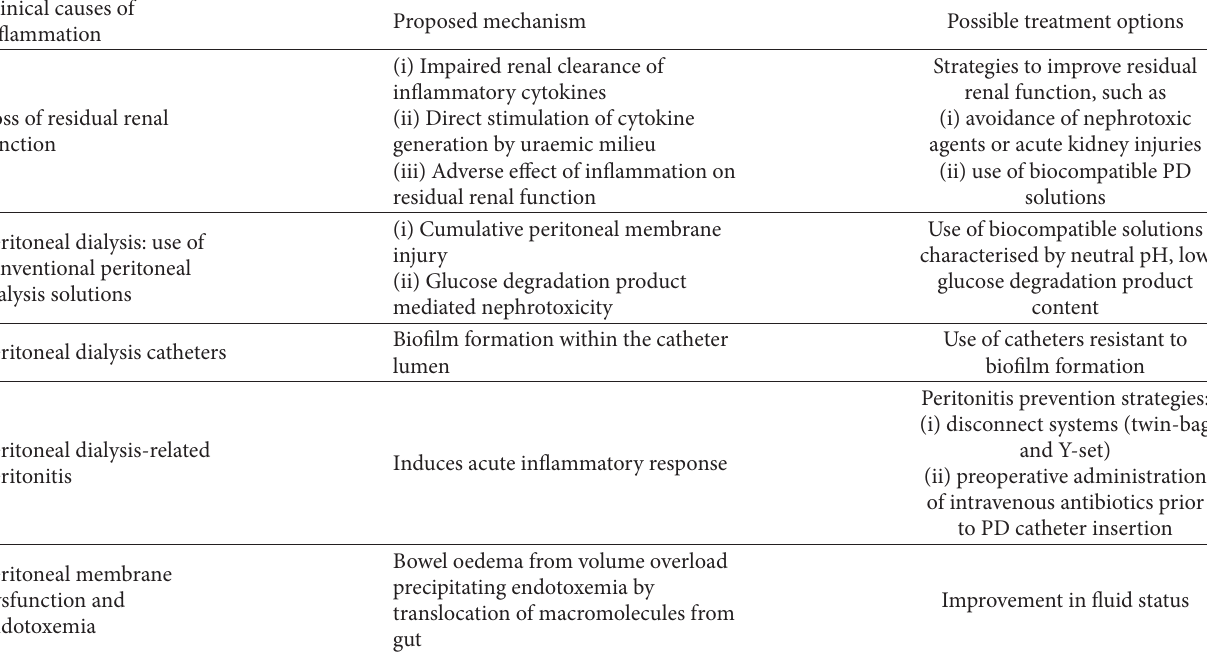
Table 1: Summary of proposed mechanisms underlying clinical causes of inflammation in peritoneal dialysis patients and possible treatment